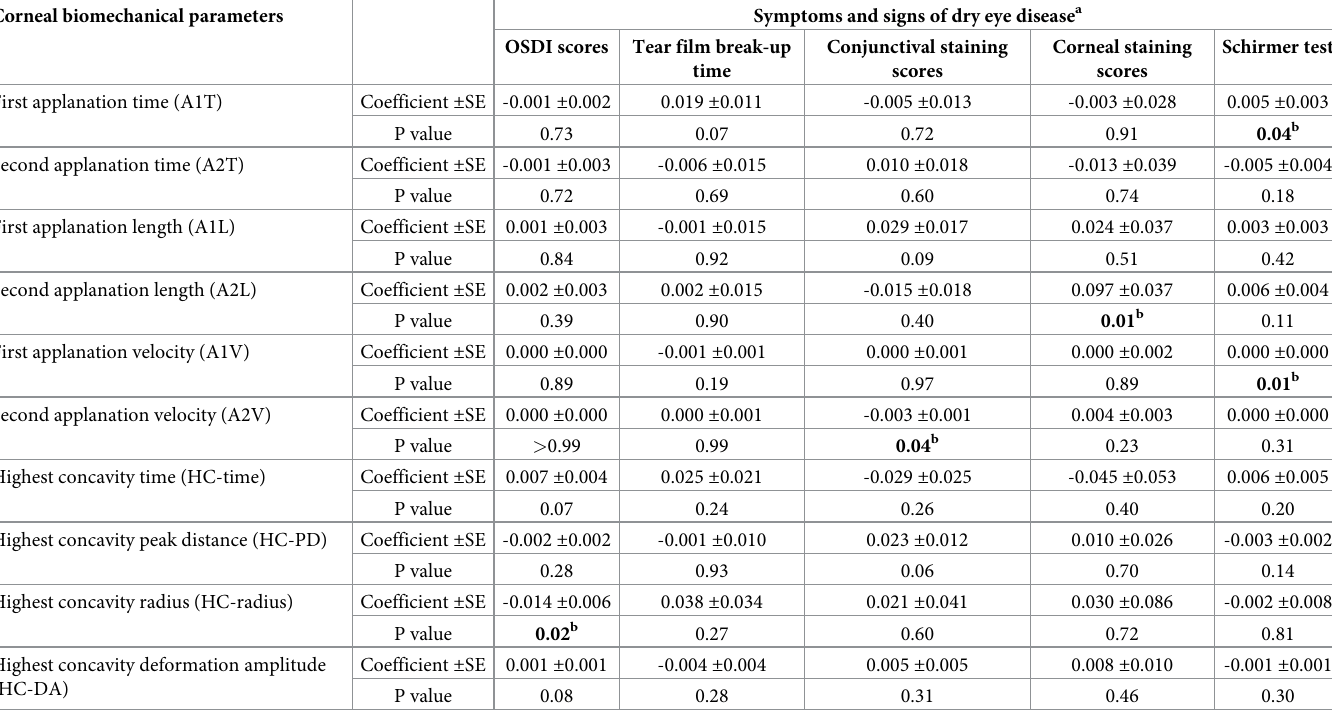
Table 1. The associations between symptoms and signs of dry eye disease and corneal biomechanical parameters of all participants. Corneal biomechanical parameters Symptoms and signs of dry eye disease a